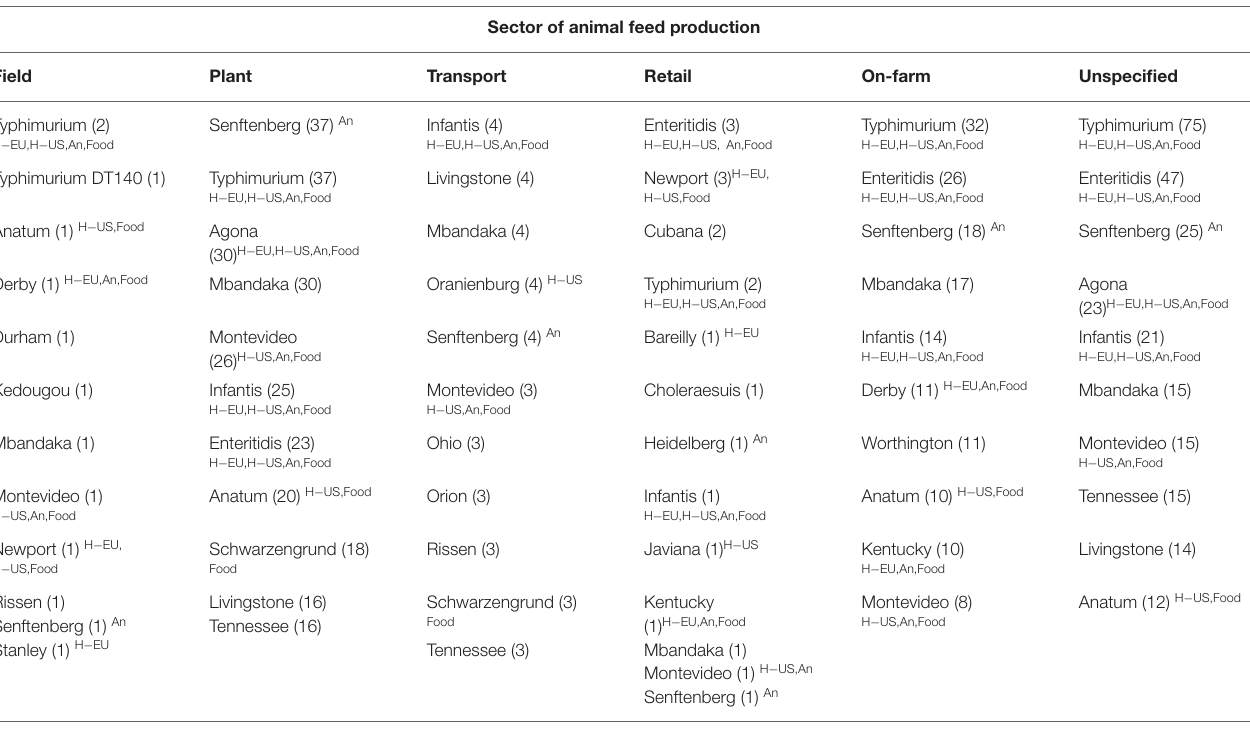
TABLE 4 | Ten Salmonella serovars most frequently investigated in animal feeds, feed equipment, or feed environment by sector of animal feed production (number of studies in which serovar was reported, alphabetic listing for tied results). Sector of animal feed